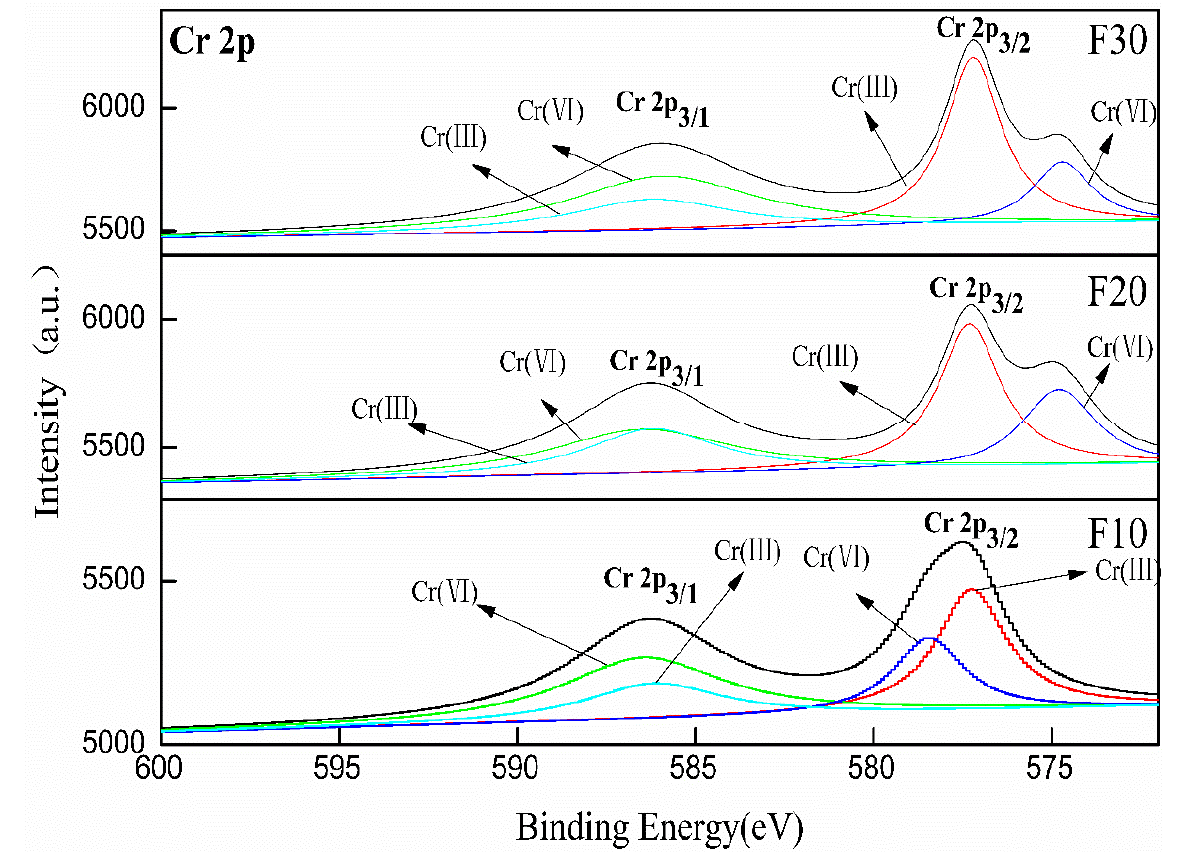
Figure 8. XPS patterns of Cr in different samples (F10, F20, F30).